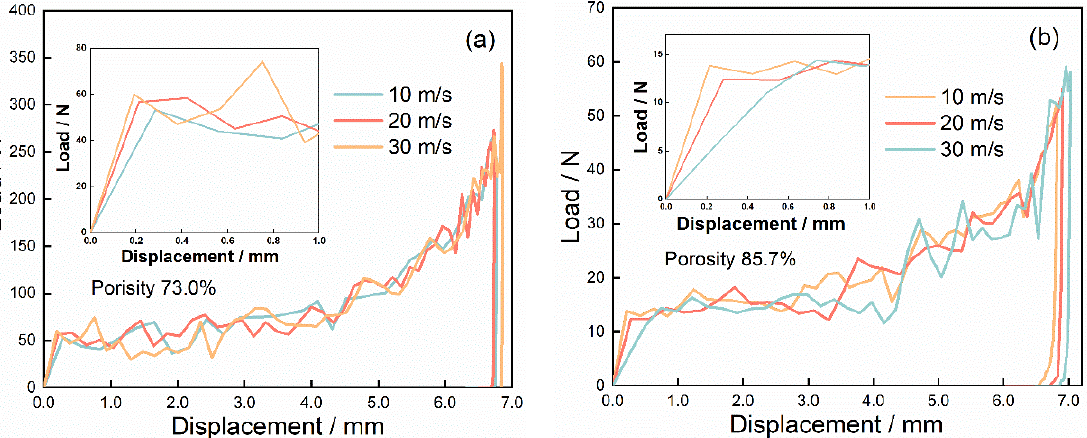
Figure 17. Load–displacement curves of specimen with ( a ) 73.0% porosity and ( b ) 85.7% porosity at various impact velocities.